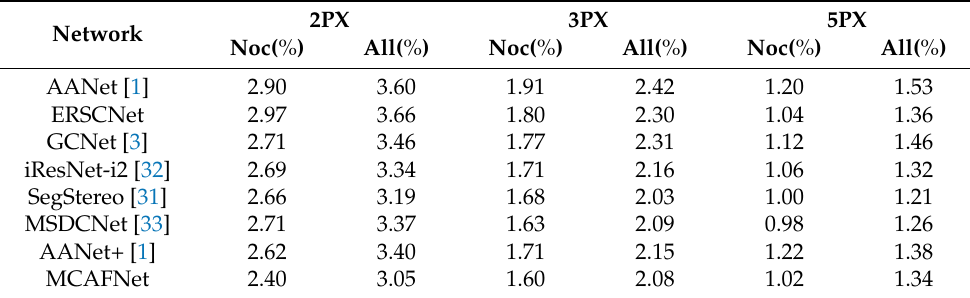
Table 4. Comparative experiment on the KITTI2012